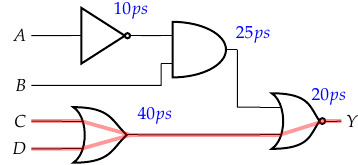
Figure 4. Critical paths (in